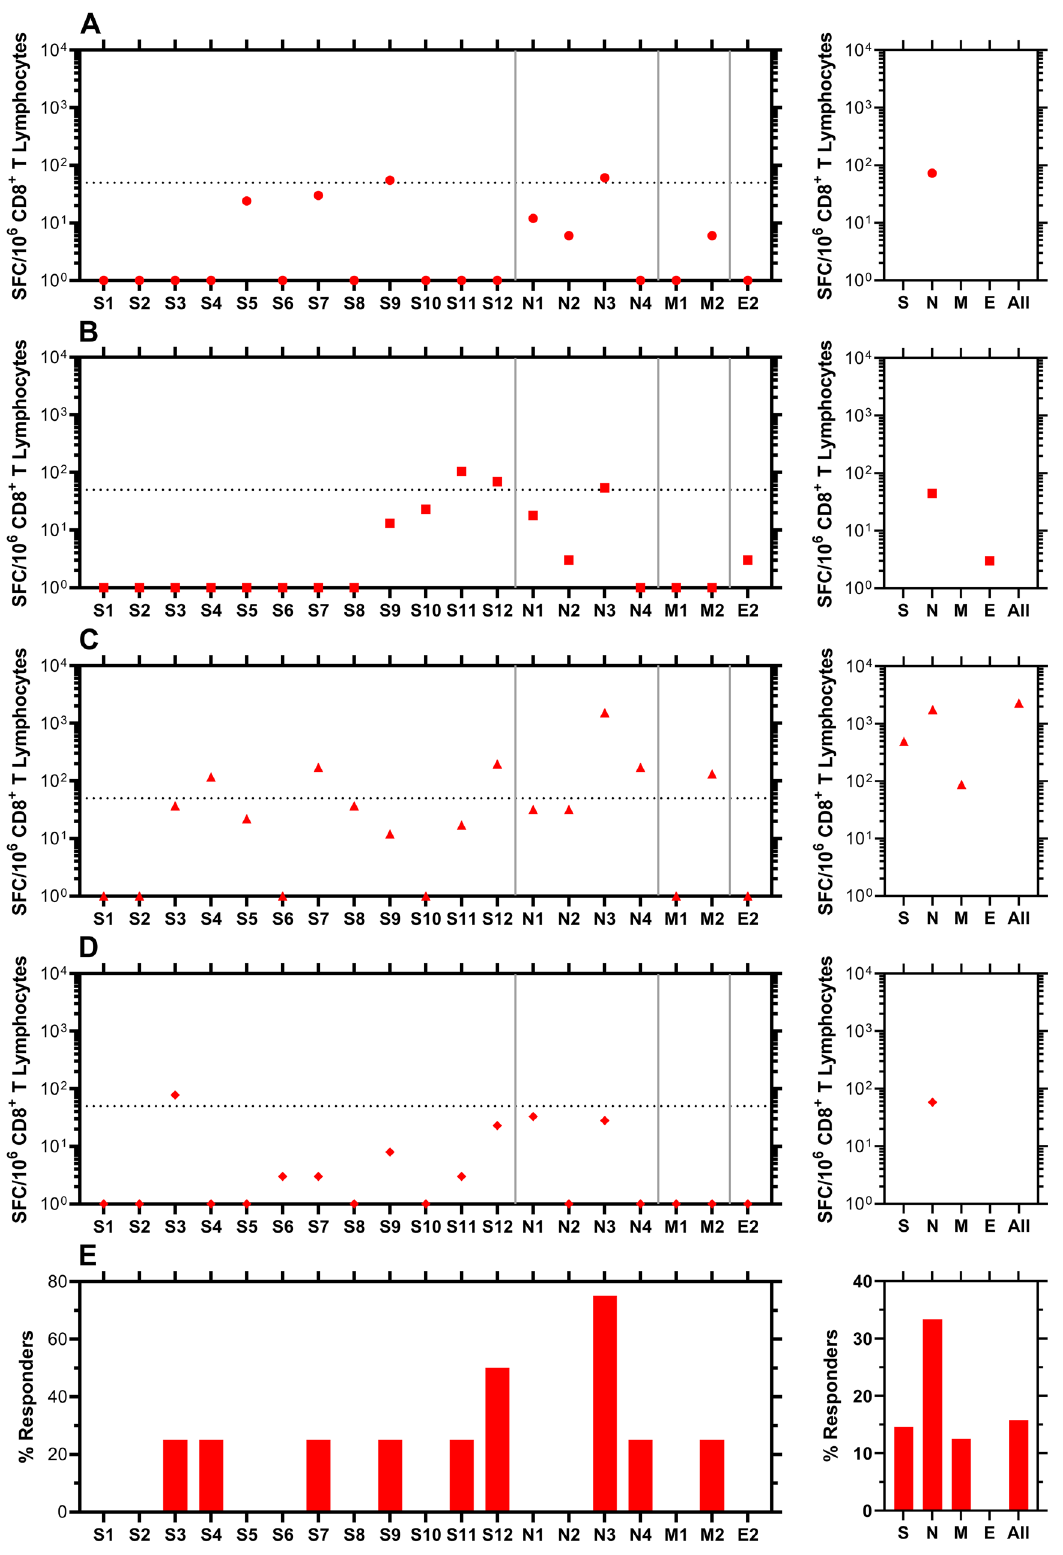
Unlike with other microorganisms (e.g., generation time in bac- terial growth), the complexities of viral replication are not fully captured in a doubling model. However, due to the exponential nature of the early growth kinetics, the T d value represents a useful mathematical descriptor of viral replication rates, there-by providing a quantity that can be compared across studies.